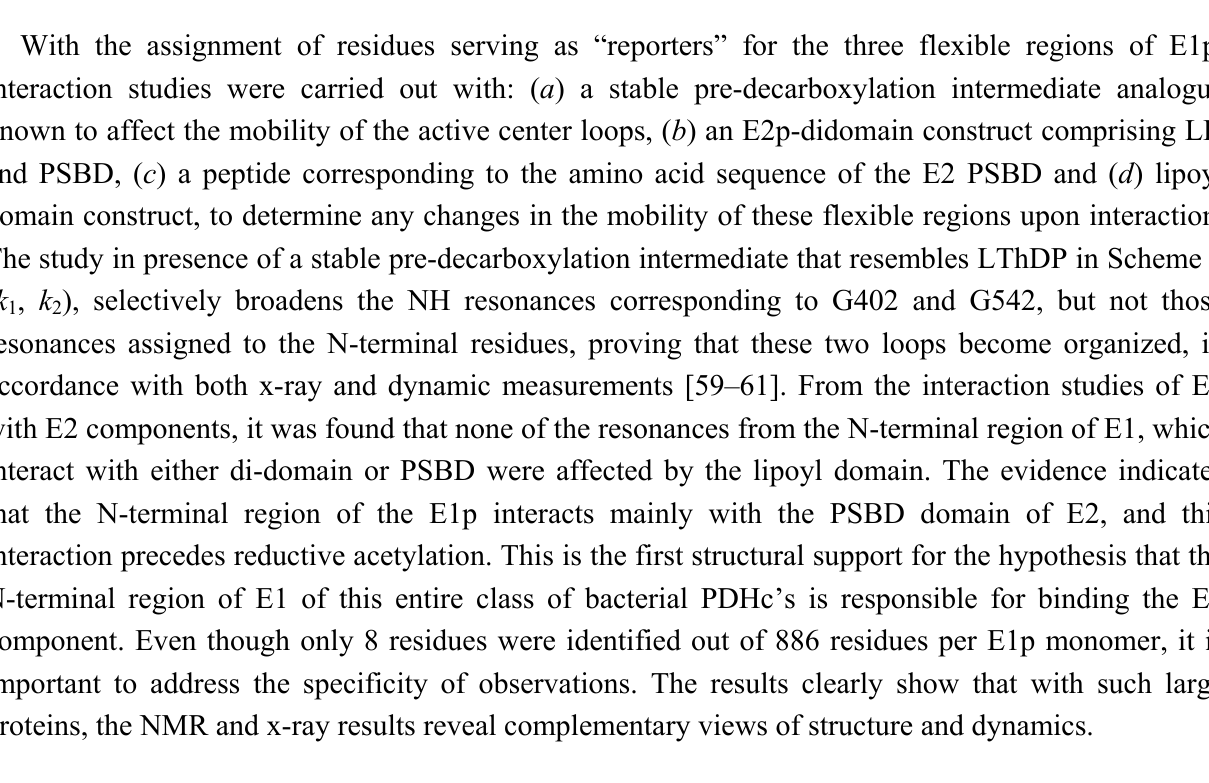
Table 4. Experimentally estimated and theoretical number of resonances on E1ec in the three flexible regions in the 15 N- 1 H HSQC spectra